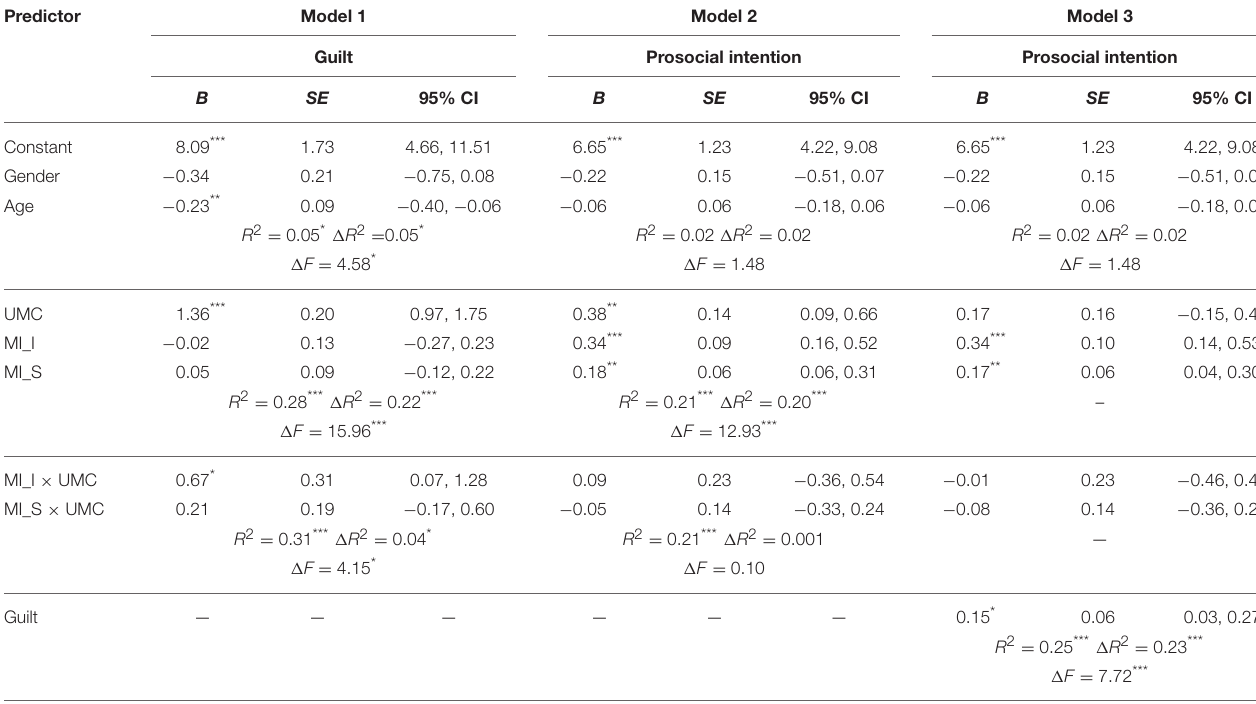
TABLE 4 | Results of hierarchical regression analysis for moderated mediation ( N = 162).